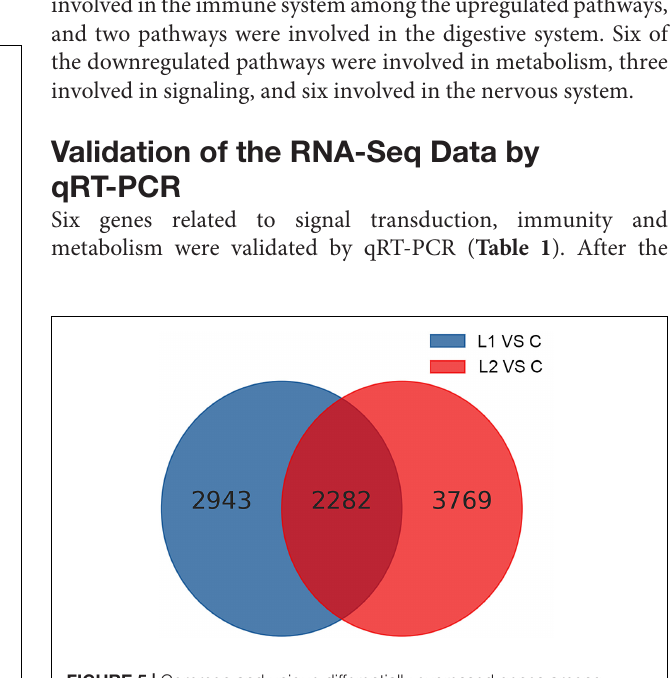
were nine involved in metabolism, two in the immune system, and one and three in signaling and the nervous system, respectively.